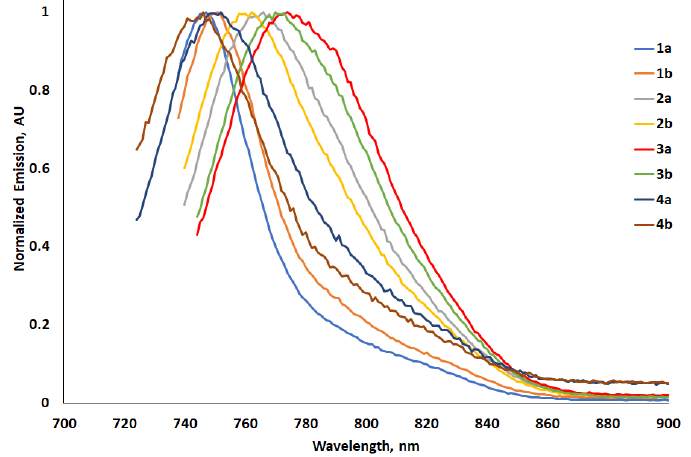
Figure 7. Emission spectra of 1a-b , 2a-b , 3a-b , and 4a-b in DMSO. All spectra are recorded at a concentration of 10 μM. λ abs was used as the excitation wavelength for λ em .